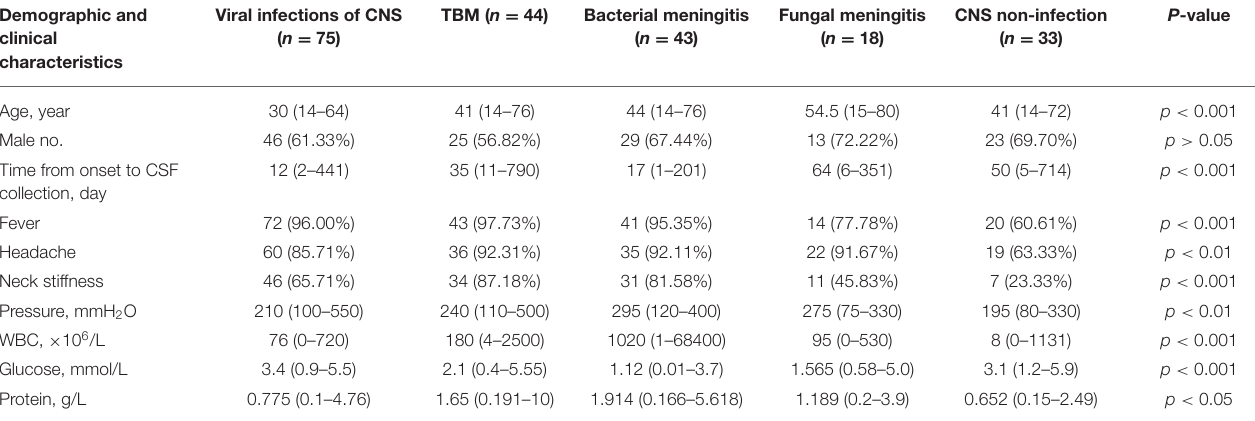
TABLE 1 | Demographic and clinical characteristics of the 213 patients. Demographic and clinical